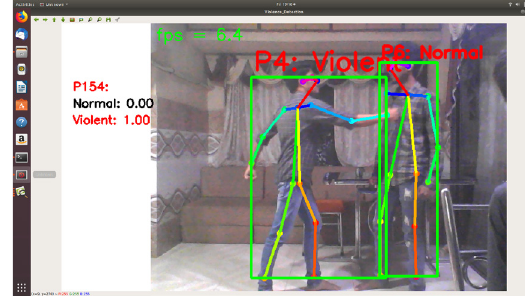
Fig. 8. Action: Violent